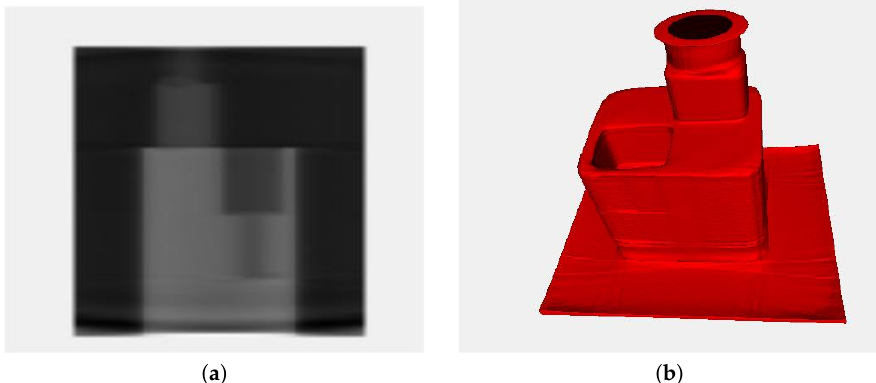
Figure 12. ( a ) One projection of the original shape. ( b ) Reconstruction of a 3D